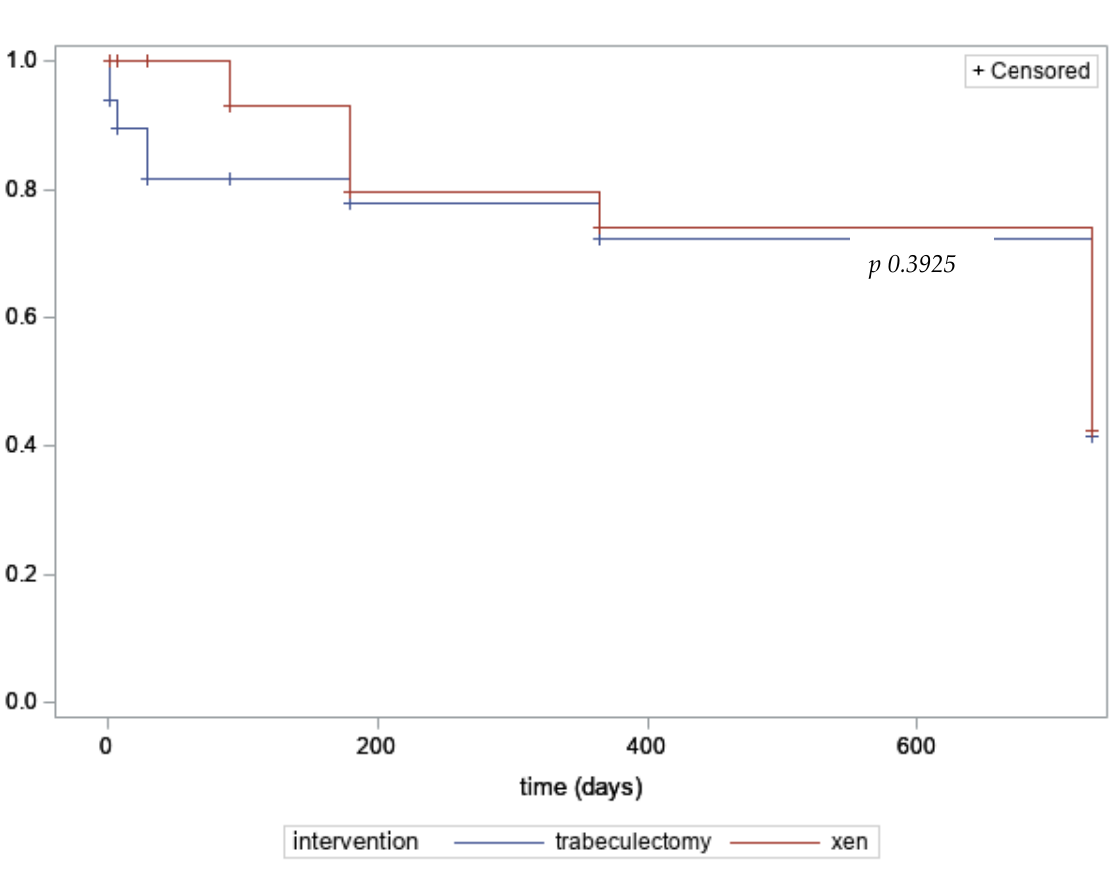
Figure 1. Kaplan – Meier curves for success of estimated probability (%). Figure 1. Kaplan–Meier curves for success of estimated probability (%).